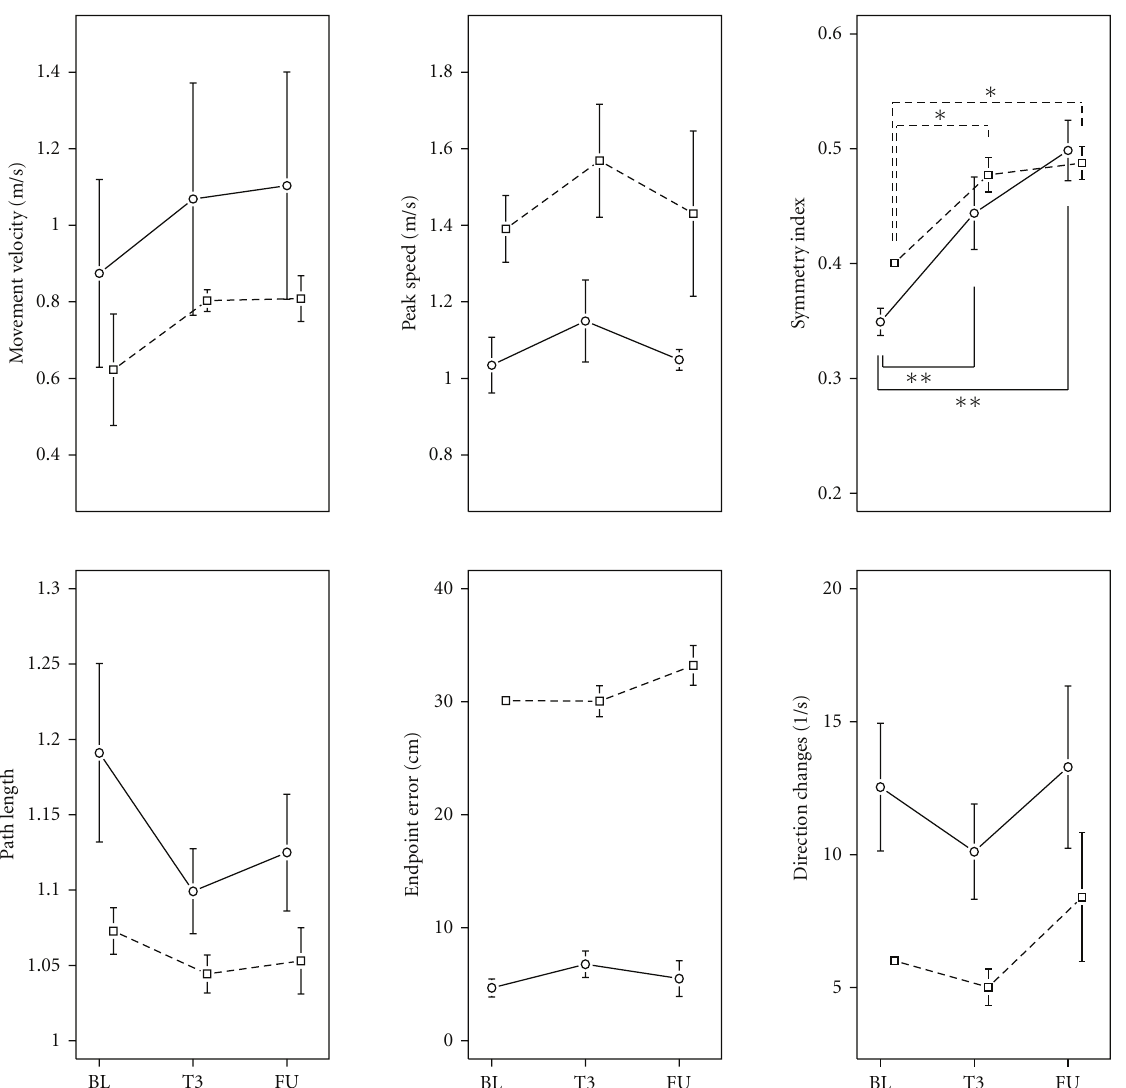
Figure 2: Pointing movements. Means ± 1 SE at baseline (BL, mean of B1 and B2), at the end of the training period (T3) and at follow- up 2 weeks after the end of the training period (FU). For the symmetry index performance at T3 and FU was significantly di ff erent from performance at BL for both arm and leg movements. ∗ P < 0 . 05, ∗∗ P < 0 . 001. Arm movements: solid line, leg movements, dashed line.